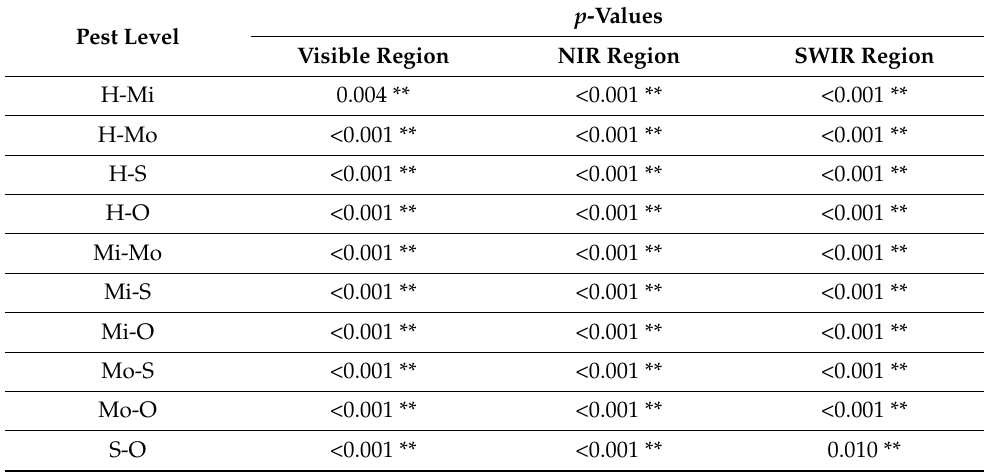
Figure 4. Moso bamboo leaves in different damage states and their spectral information: ( a ) moso bamboo leaves; ( b ) spectral information. Table 3. Paired t -test of spectra for leaves with different damage